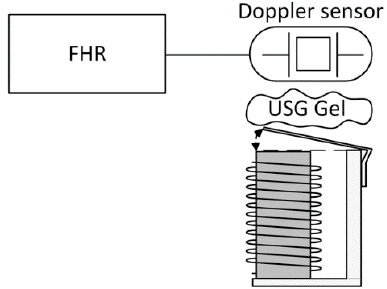
Figure 5. Positioning of the ultrasound CTG probe on FHRS actuator-relay .